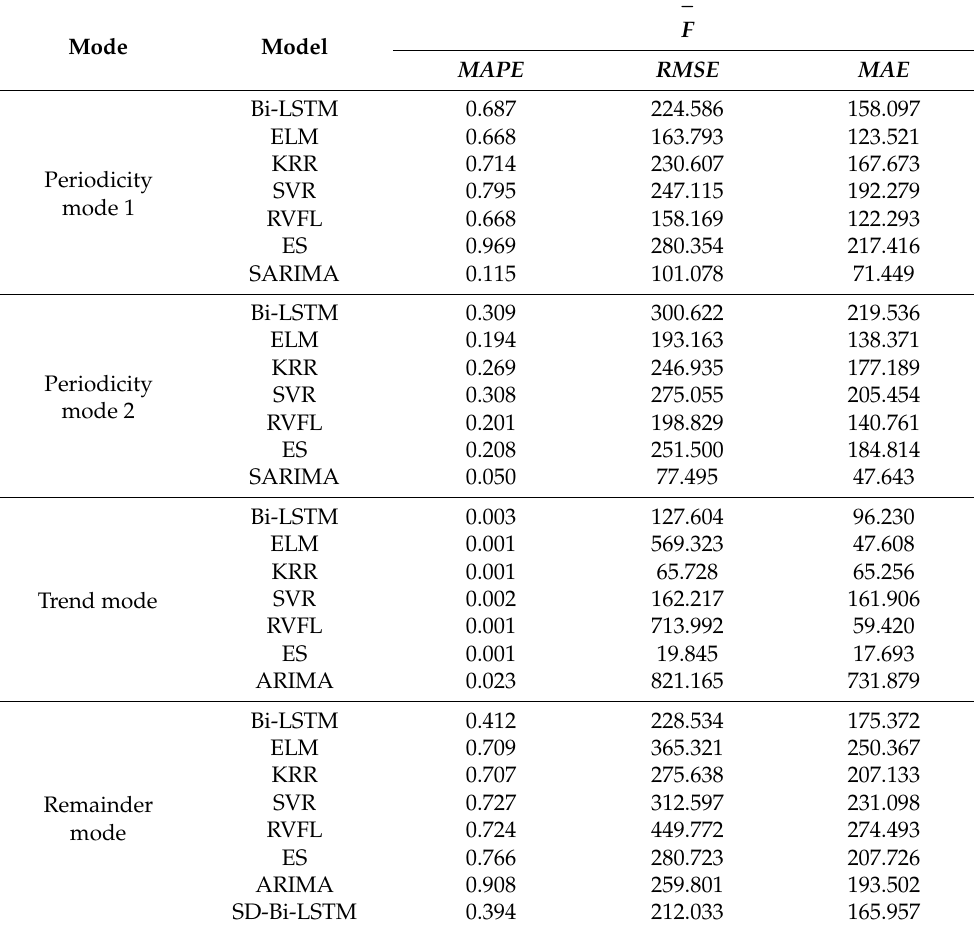
Table 5. Average prediction performance of the candidate